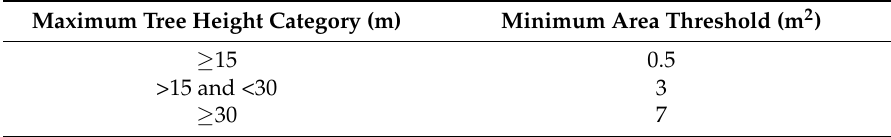
Table 5. Minimum area thresholds for automatically delineated tree crowns.